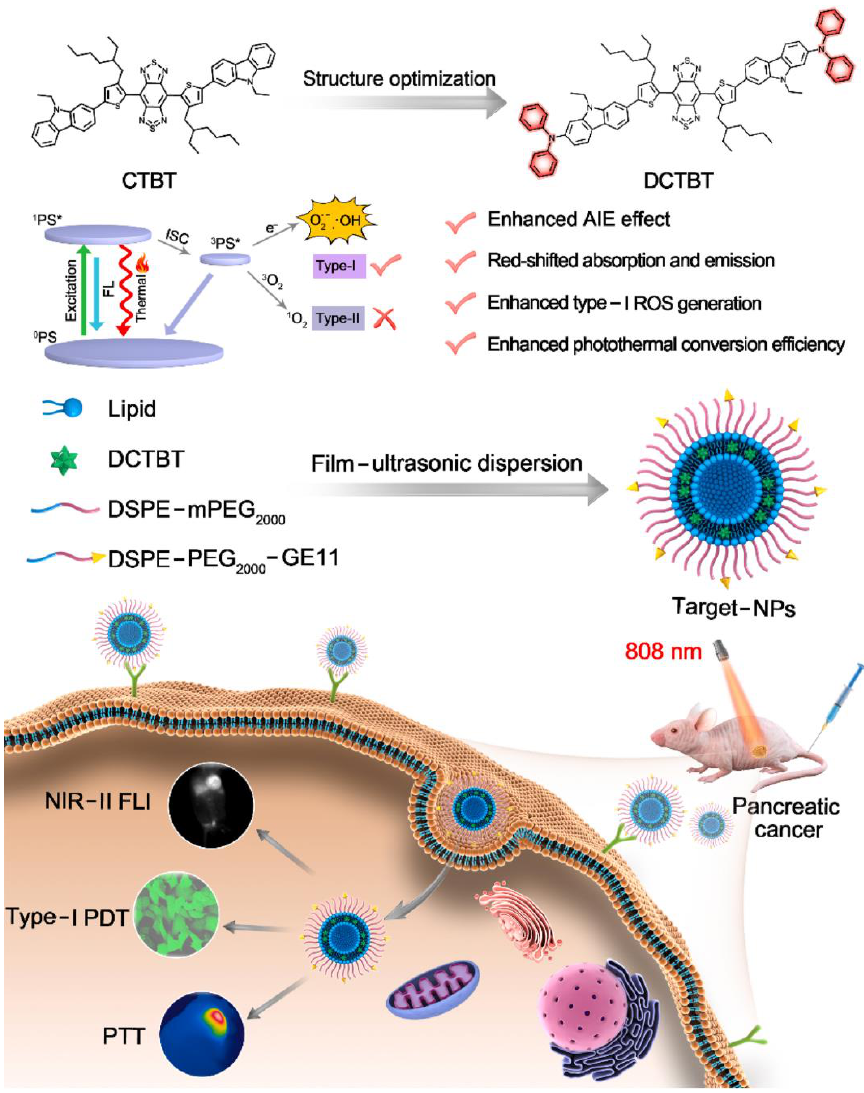
Figure 26. Schematic illustration of DCTBT, and the application on NIR-II FLI-guided Type-I PDT-PTT. Reprinted with permission from Ref. [174]. Copyright 2022 Elsevier Ltd.